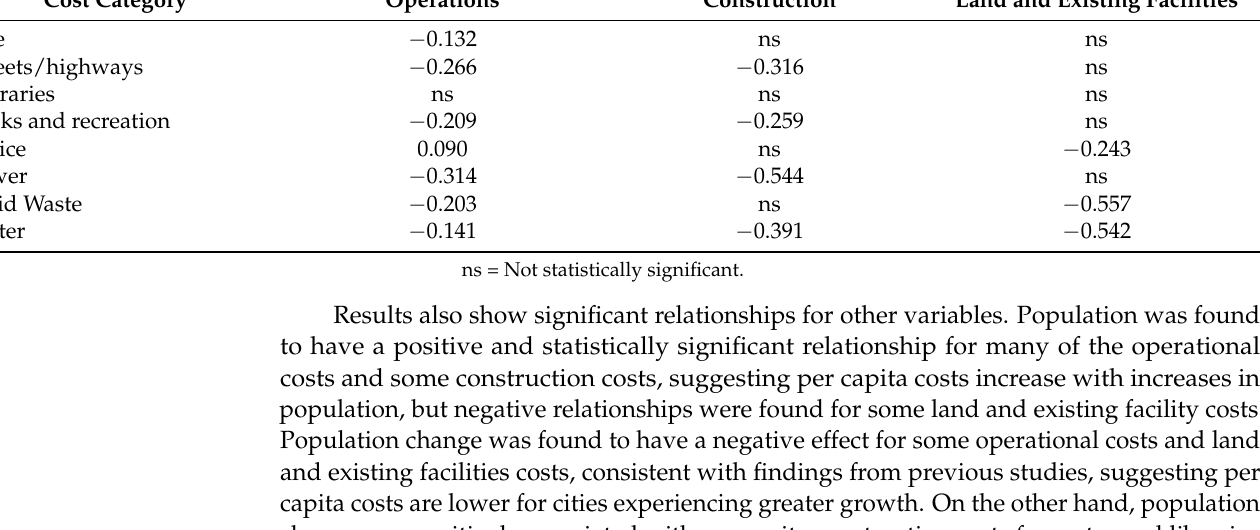
Table 6. Estimated elasticities of per capita expenditures with respect to population-weighted density. Cost Category Operations Construction Land and Existing